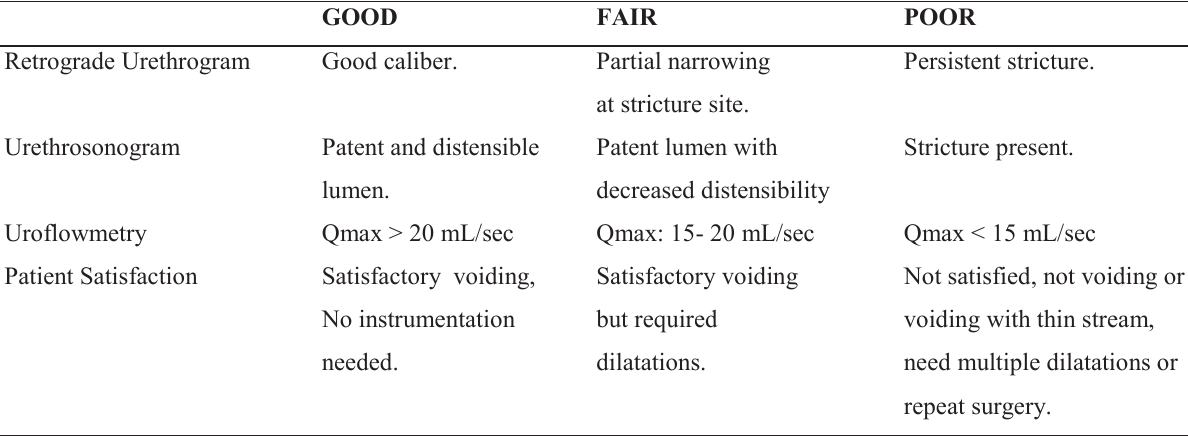
Table 2 - Postoperative Result Assessment Criteria. GOOD FAIR POOR Retrograde Urethrogram Good caliber. Partial narrowing Persistent stricture. Urethrosonogram Patent and distensible Patent lumen with lumen. decreased